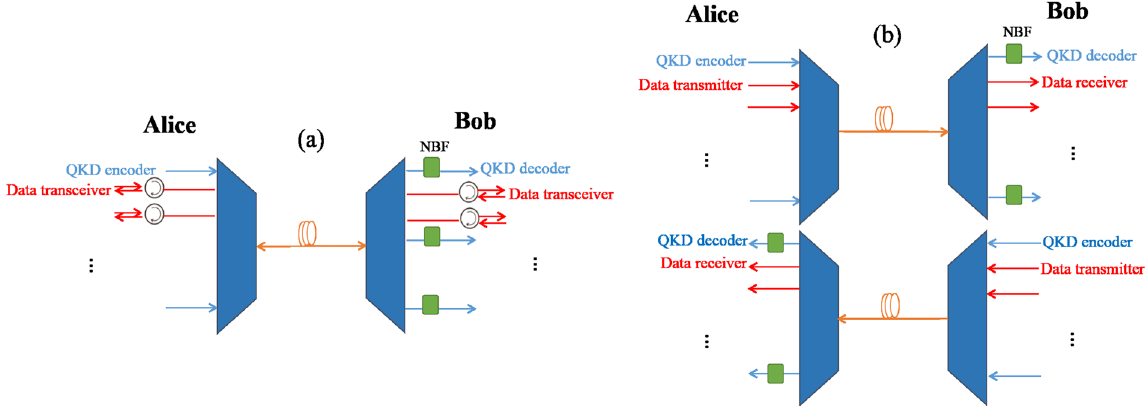
Figure 1. Hybrid DWDM link with multiple quantum and classical channels: ( a ) A full-duplex DWDM system over a single-mode fiber. Each classical channel is equipped with optical circulators to enable the transmission of signals in both directions on the same wavelength. Quantum signals travel from Alice to Bob. ( b ) A dual-fiber DWDM system, where forward and backward data signals are transmitted via different fibers. Quantum signals travel along the same direction as the classical